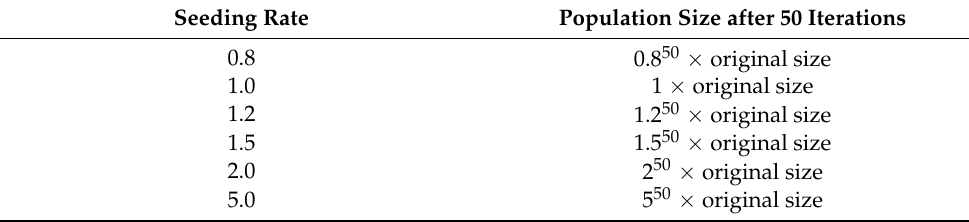
Table 2. Seeding rate and population